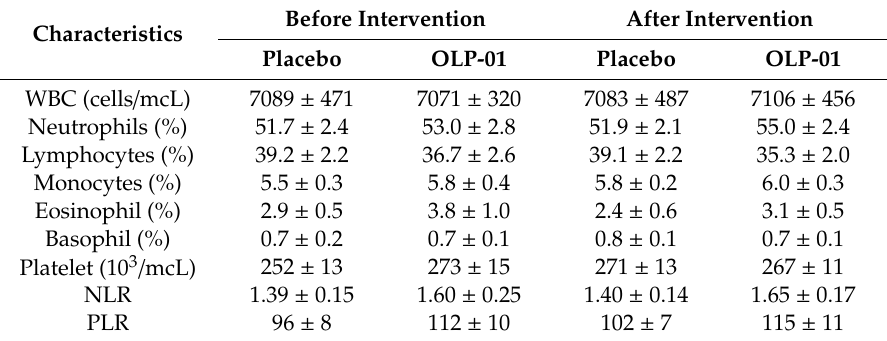
Table 4. E ff ects of OLP-01 on Complete Blood Count